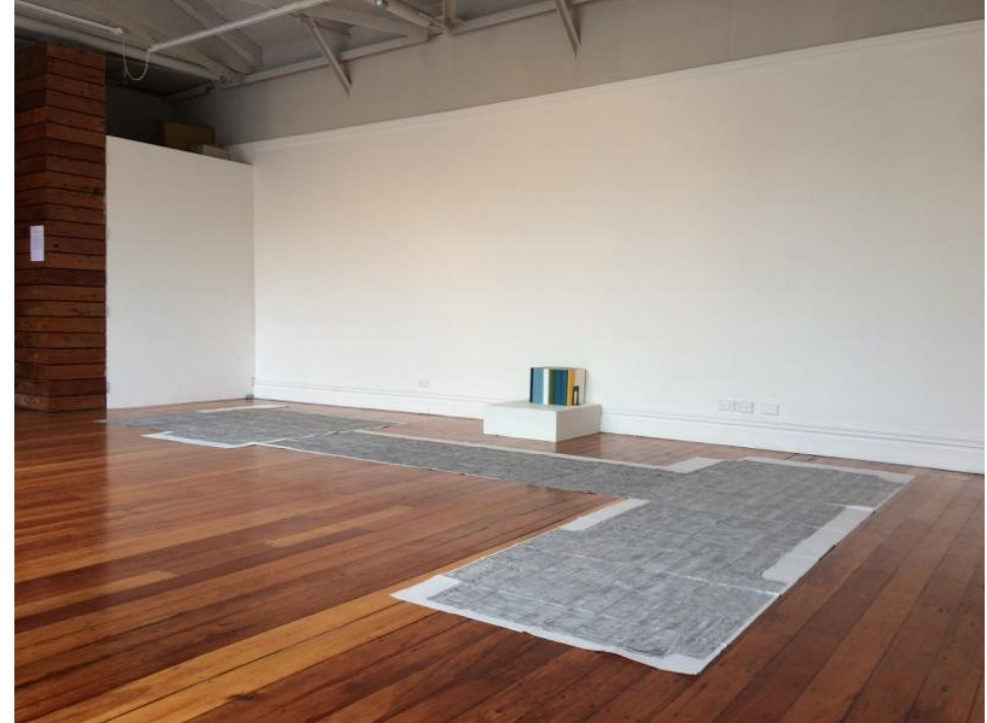
Figure 3. The floor we walk on , 2015. Enjoy Public Art Gallery, Te Whanganui-a-tara. Installation detail of Something Felt, Something Shared , curated by Emma Ng. Graphite on paper, dimensions variable. Photo: Andrew Matautia. Collection of Chris Parkin.